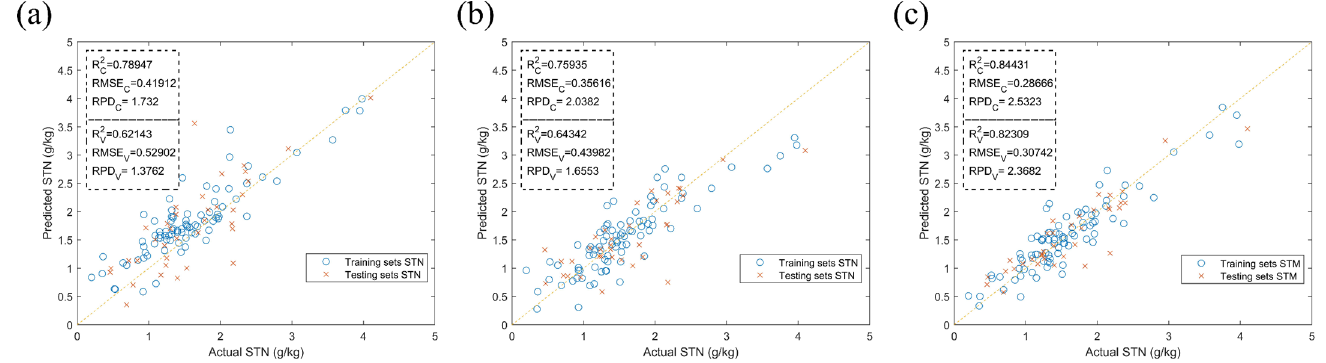
Figure 5. Graph of prediction results of three models for initial modeling. ( a ) Initial modeling BPNN model prediction results. ( b ) Initial modeling ELM model prediction result. ( c ) Initial modeling PLSR model prediction result.